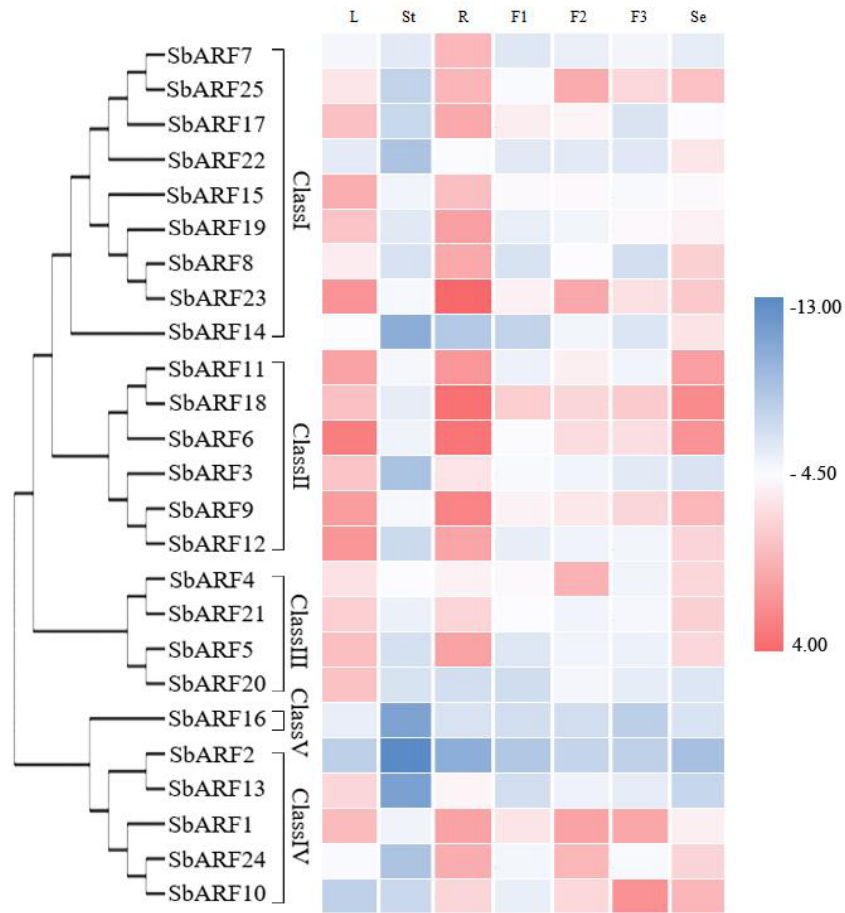
Figure 4. Expression profiles of SbARF genes in different tissues. The heatmap was generated based on the relative expression values of 25 SbARFs genes obtained by qRT-PCR in seven different tissues and organs. The red and blue color scale represents log2-transformed values and indicates relatively high or low expression, respectively. Every sample is three biological replicates. L, leaves; St, stem; R, root; F1, immature inflorescence; F2, mature inflorescence; F3, post-flowering inflorescence; Se, seeds.